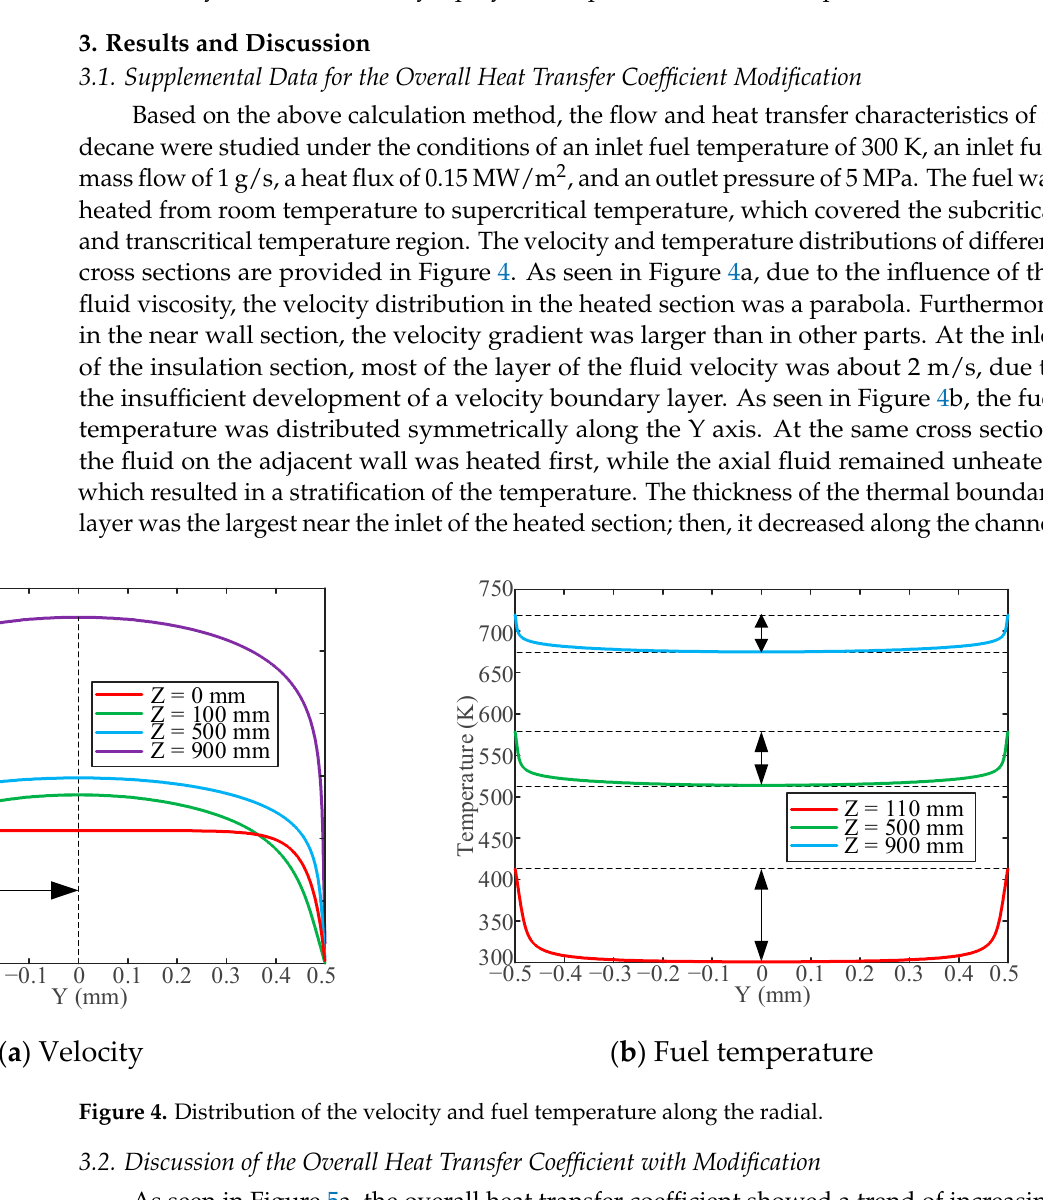
Figure 3. Schematic diagram of the cooling channel.